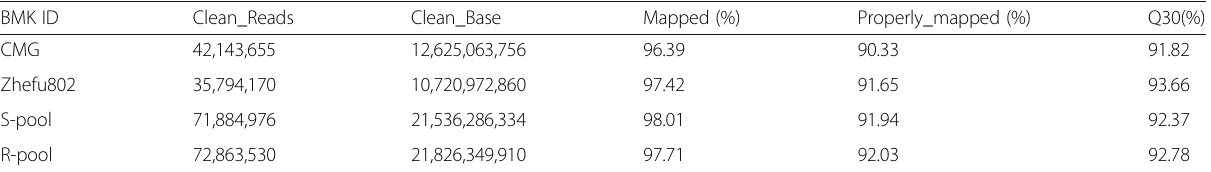
Table 1 Coverage of the reads mapping to the Nipponbare reference genome from resequencing of the indica rice variety Zhefu802 and a rice landrace CMG using Hiseq 2000.